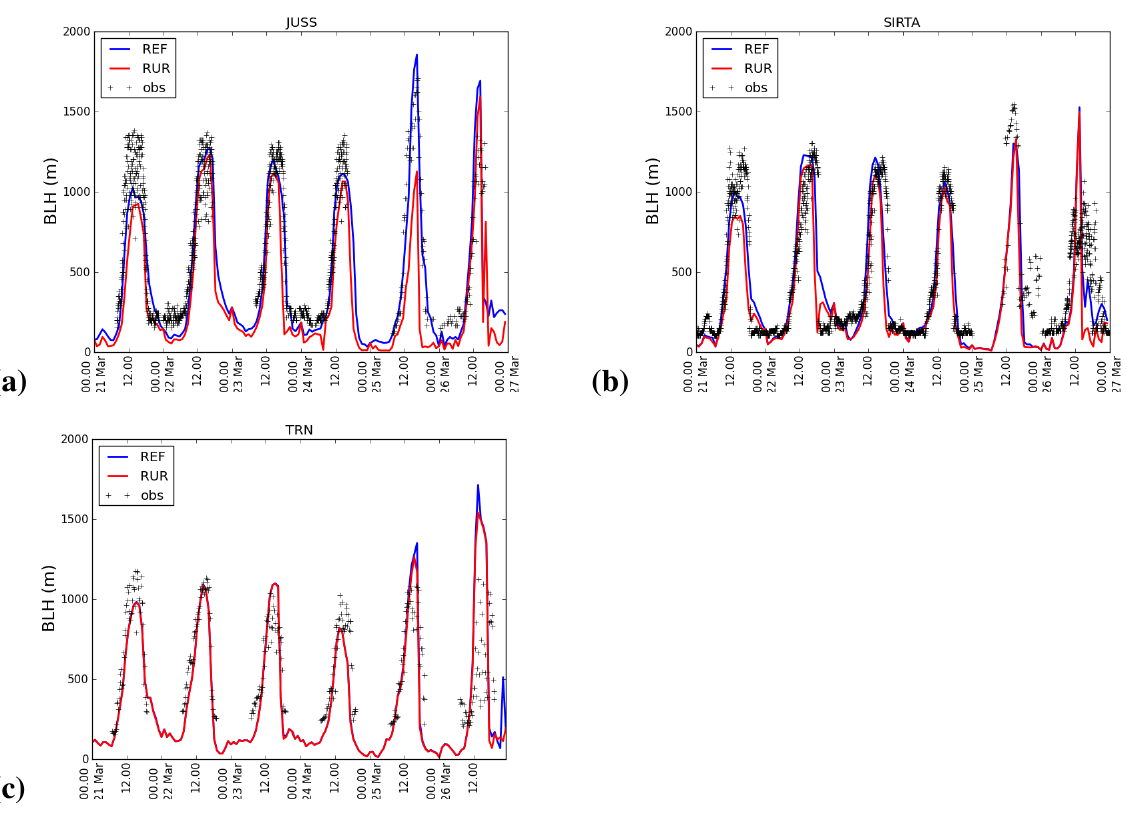
Fig. 7. Time series of BLH (in metres a.g.l. (AGL)) for 21–26 March at JUSS ( (a) , urban site), SIRTA ( (b) , suburban site) and TRN ( (c) , rural site).